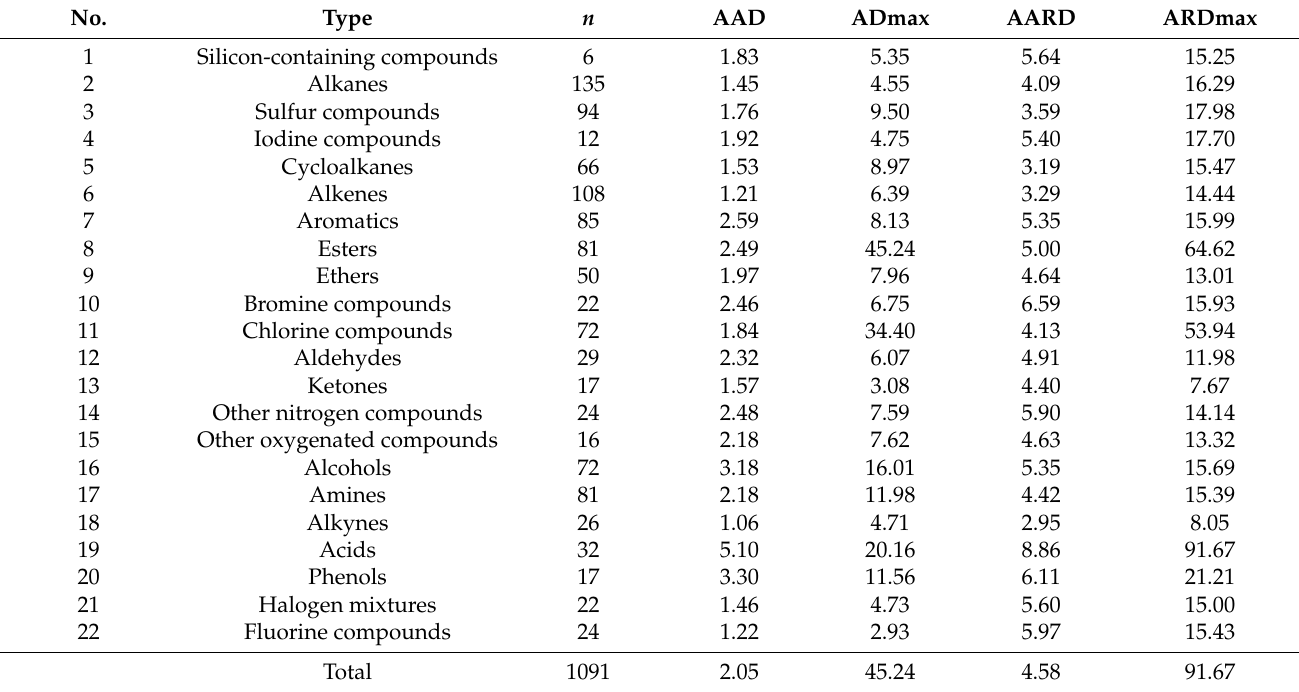
Table 6. Classification and summary of prediction results by Gani